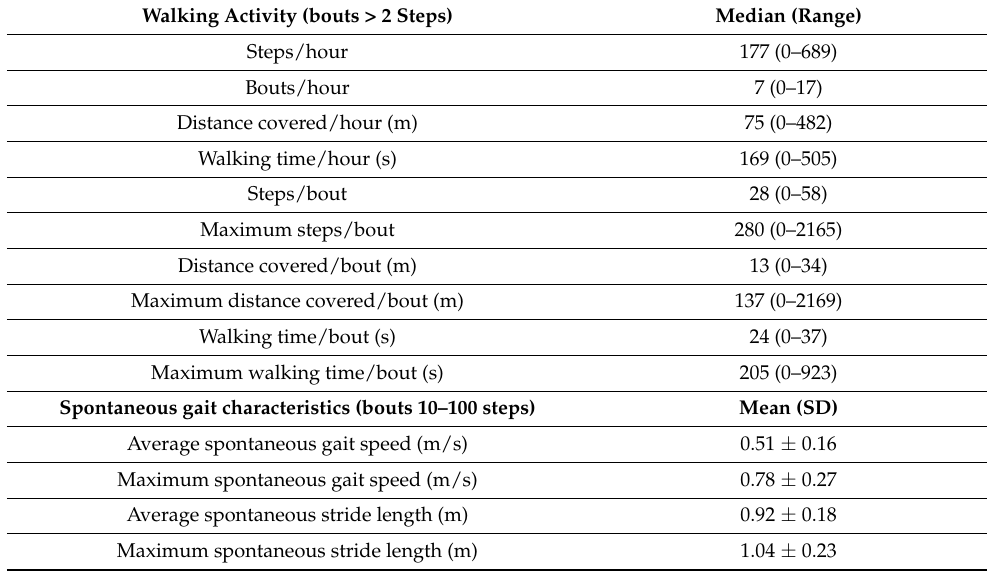
Table 3. Gait performance (beyond therapy time): walking activity and spontaneous gait characteristics.